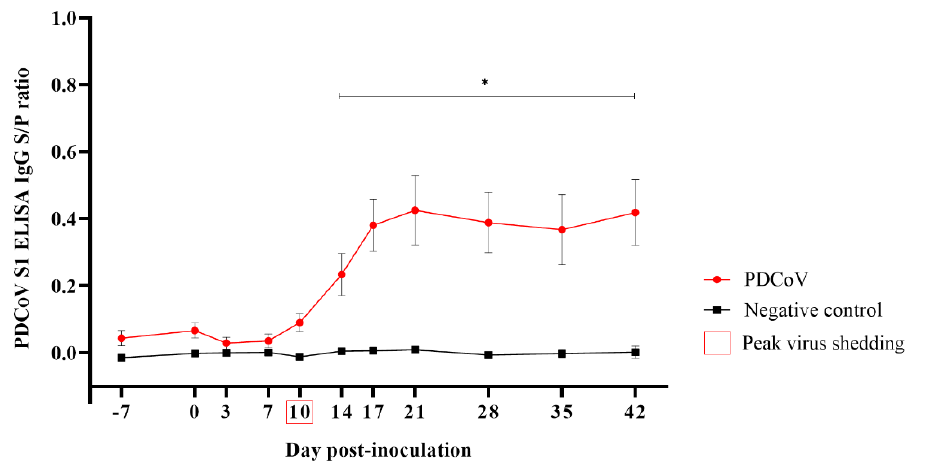
Figure 3. Porcine deltacoronavirus (PDCoV) S1 ELISA IgG responses [mean sample-to-positive (S/P) values, standard error of the mean (SEM)] ( y -axis) at − 7, 0, 3, 7, 10, 14, 17, 21, 28, 35, and 42 days post-inoculation (DPI) ( x -axis), in 7-week-old grower pigs experimentally inoculated with PDCoV ( n = 12) or mock-inoculated ( n = 12) with culture medium. Error bars represent the standard error of the mean SEM, and * denotes statistical differences ( p < 0.05).